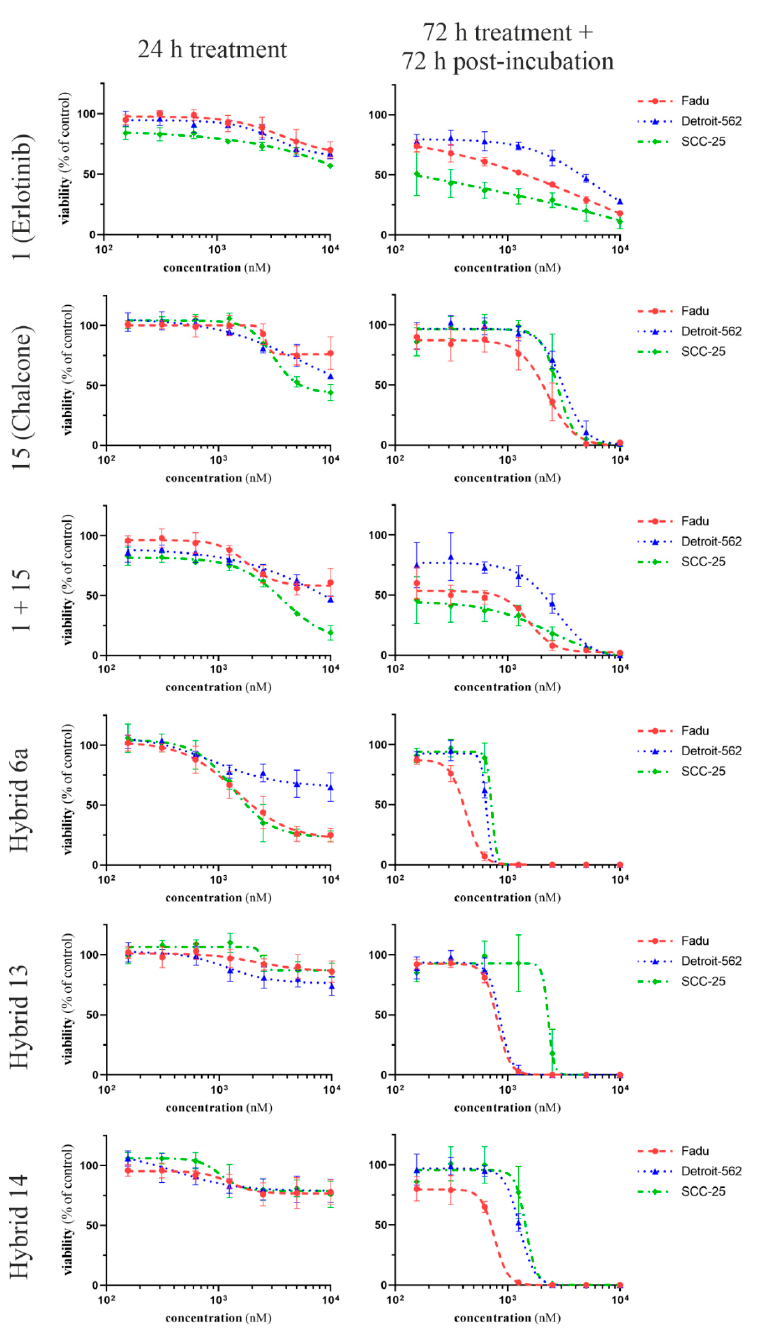
Figure 3. Dose- and time-dependent effects of the selected hybrid molecules on the viability of Fadu, Detroit 562 and SCC-25 cells. Hybrids ( 6a , 13 and 14 ) and the reference compounds ( 1 : erlotinib, 15 : chalcone and their combination in 1:1 ratio) were applied for 24 h or 72 h followed by 72 h postincubation period. Cell viability was determined by CellTiter-Glo assay. Curves were fitted by GraphPad Prism 8 software (nonlinear regression, variable slope; n = 4). Erlotinib significantly inhibited the viability of all tested cancer cells in the nano- molar range; however, it was far from being able to completely eradicate the cancer cells even at the highest concentration applied (10 μ M). On the other hand, the effect of 15 (reference chalcone) was only detectable in the micromolar range. It must be pointed out